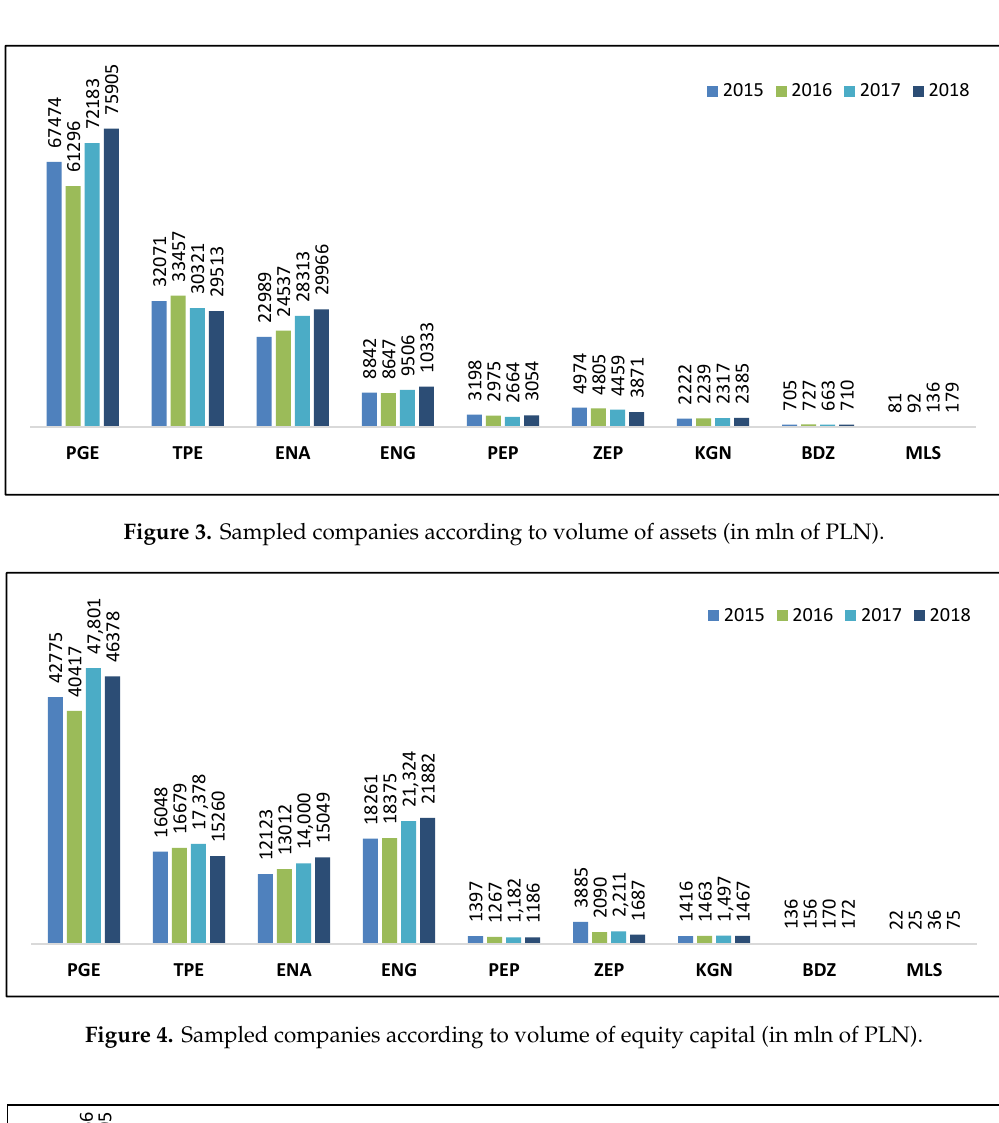
Figure 2. Sampled companies according to sales revenues (in mln of PLN).